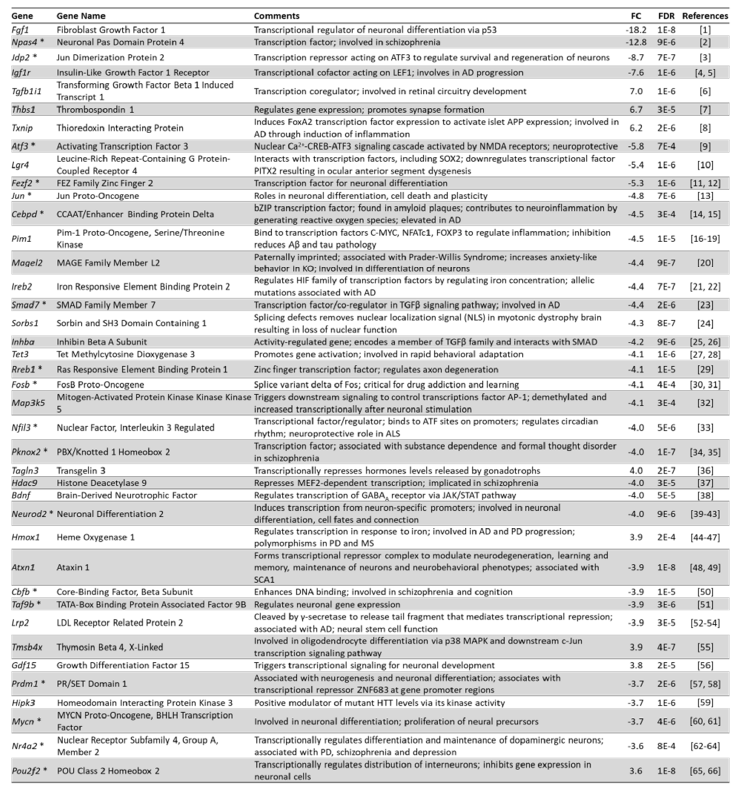
Figure 15. Arc controls genes involved in transcriptional regulation. Shown are the top 40 genes with neuronal relevance. An asterisk (*) indicates transcription factors. ATF3: activating transcription factor 3; LEF1: lymphoid enhancer binding factor 1; FoxA2: forkhead box A2; APP: amyloid precursor protein; CREB: cAMP response element-binding protein; SOX2: SRY-box 2; PITX2: paired like homeodomain 2; bZIP: basic leucine zipper domain; C-MYC: MYC proto-oncogene, BHLH transcription factor; NFATc1: nuclear factor of activated T cells 1; FOXP3: forkhead box P3; HIF: hypoxia inducible factor; TGF β : transforming growth factor beta; PD: Parkinson’s disease; NLS: nuclear localisation signal; SMAD: transcription factors forming the core of the TGF β signalling pathway; AP-1: activator protein 1; ALS: amyotrophic lateral sclerosis; MEF2: monocyte enhancer factor; GABA A : γ -aminobu- tyric acid type A; JAK/STAT: Janus kinases/ signal transducer and activator of transcription; SCA1: spinocerebellar ataxia type 1; MAPK: mitogen- activated protein kinase; ZNF683: zinc finger protein 683; HTT: huntingtin. References: 1 [292], 2 [293], 3 [294], 4–5 [114,295], 6 [132], 7 [296], 8 [297], 9 [298], 10 [299], 11–12 [300,301], 13 [302], 14–15